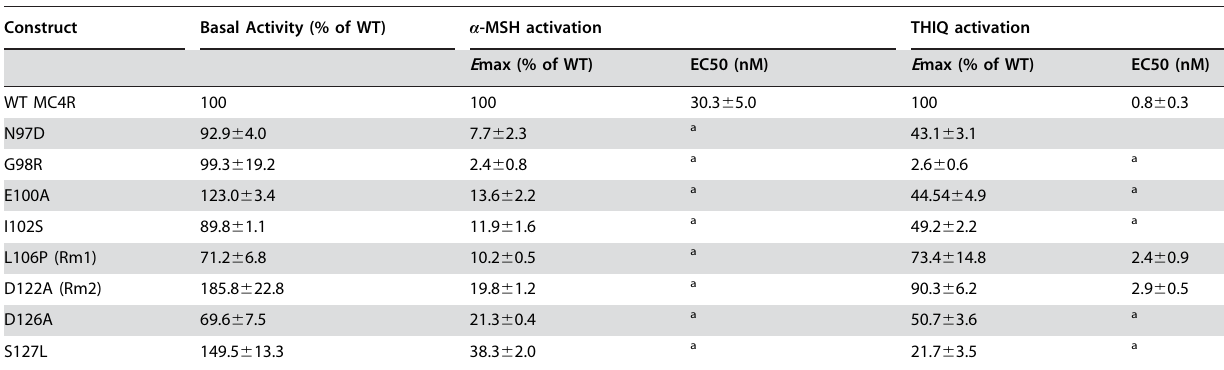
Table 1. Functional characterization of MC4R EL1 mutations. .. ... .... ... ... .... ... ... .... ... ... .... ... ... .... ... ... .... ... ... .... ... ... .... ... ... .... ... ... .... ... ... .... ... ... .... ... ... .... ... ... .... ... ... . Construct